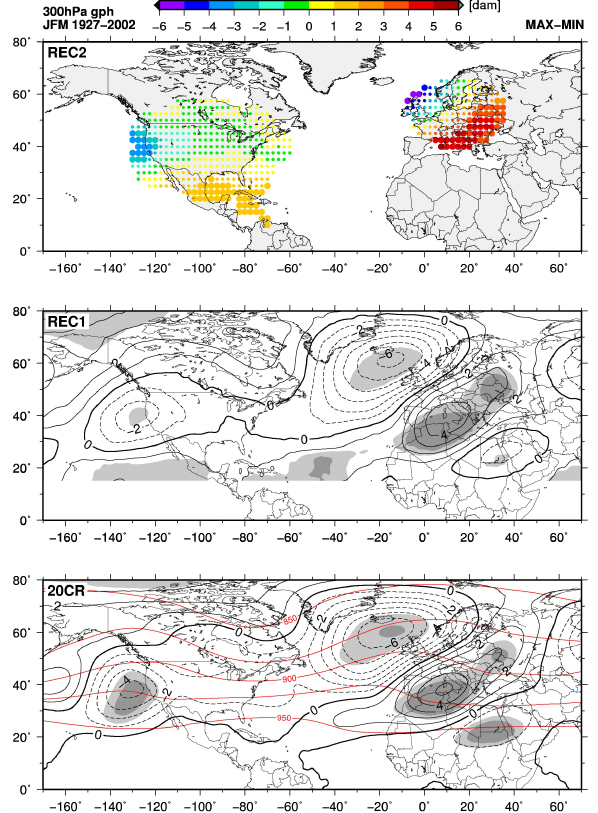
Fig. 5. Maps of differences between maxima and minima compos- ites for 300 hPa geopotential height in the REC2 reconstruction (top panel; big circles represent significant differences at 5% level after a Student’s t test), the REC1 reconstruction (middle panel) and the 20CR (bottom panel). Shadings are as explained in Fig. 3; red lines in the bottom panel represent the geopotential height climatology over the period 1927–2002. Units are dam.